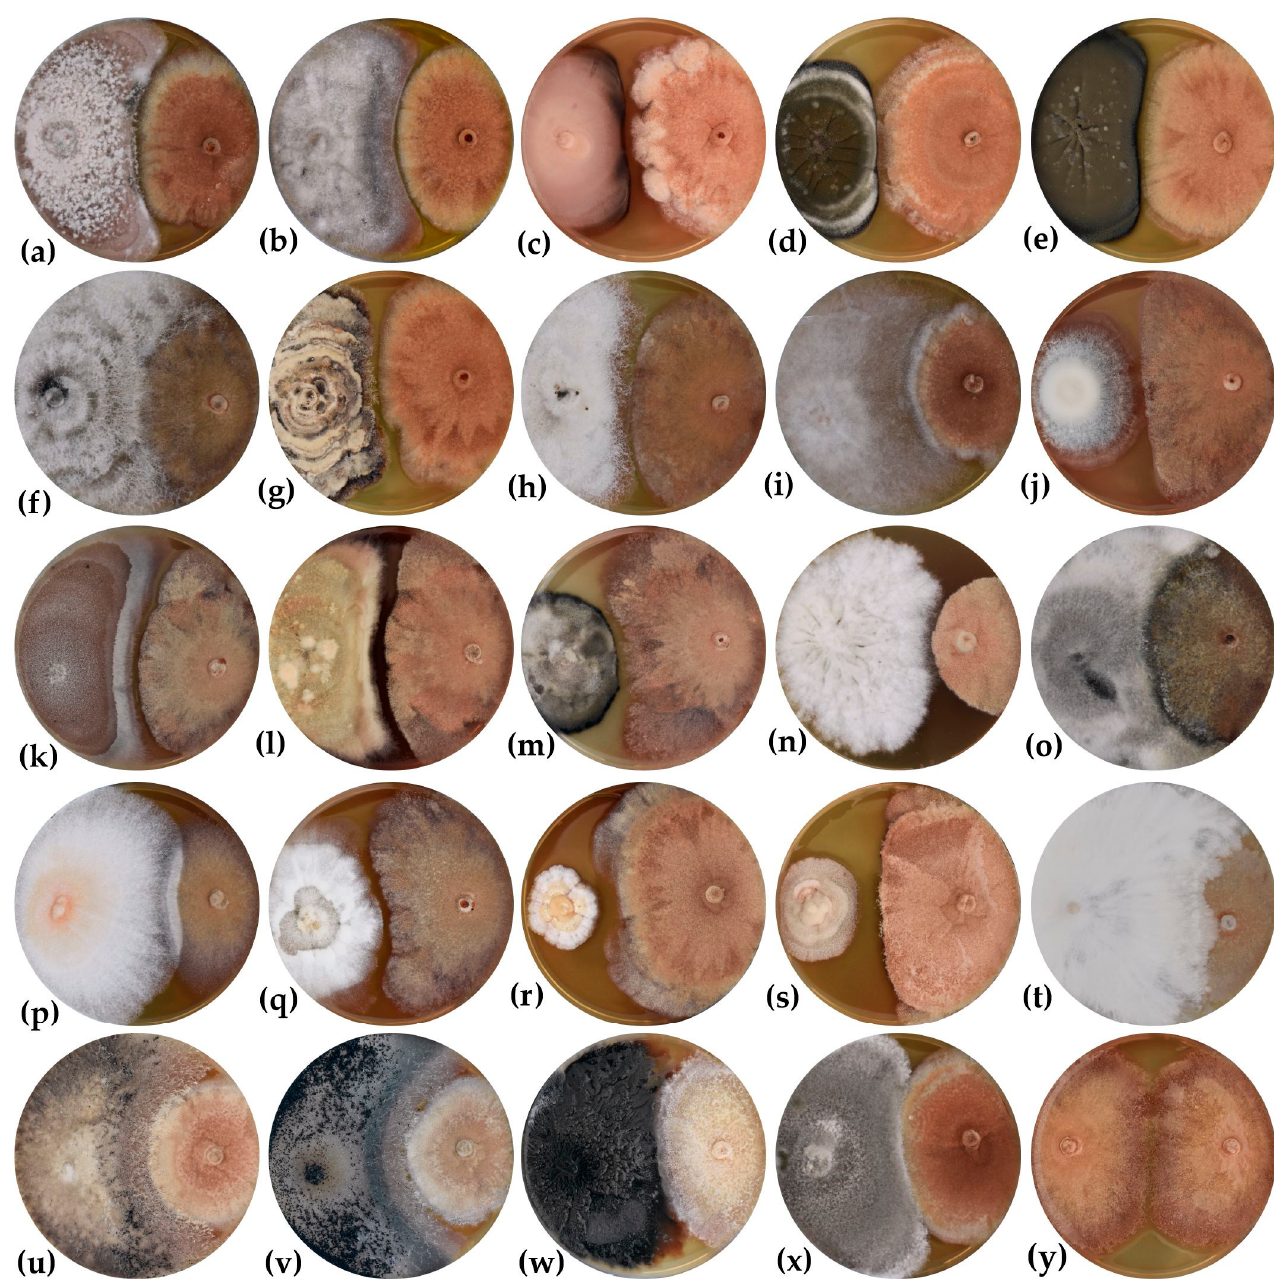
Figure 4. Mycelial interactions after 27 days of co-incubation between the isolate of Hymenoscyphus fraxineus (right) and selected isolates of endophytic fungi (left): ( a ) Alternaria infectoria , ( b ) Ascochyta medicaginicola , ( c ) Aureobasidium pullulans , ( d ) Cladosporium allicinum , ( e ) Cladosporium tenuissimum , ( f ) Diaporthe eres , ( g ) Diaporthe oncostoma , ( h ) Diaporthe rudis , ( i ) Didymella aliena , ( j ) Didymella macrostoma , ( k ) Dothiorella gregaria , ( l ) Epicoccum nigrum , ( m ) Fraxinicola fraxini , ( n ) Fusarium lateritium , ( o ) Hypoxylon fragiforme , ( p ) Lepteutypa fuckelii , ( q ) Microdiplodia sp., ( r ) Neo- fabraea vagabunda , ( s ) Phaeosphaeria sp., ( t ) Rosellinia corticium , ( u ) Sordaria fimicola , ( v ) Sordaria lappae , ( w ) Sporormiella minima , ( x ) Stemphylium vesicarium , ( y ) control—two plugs of H. fraxineus taken from the same